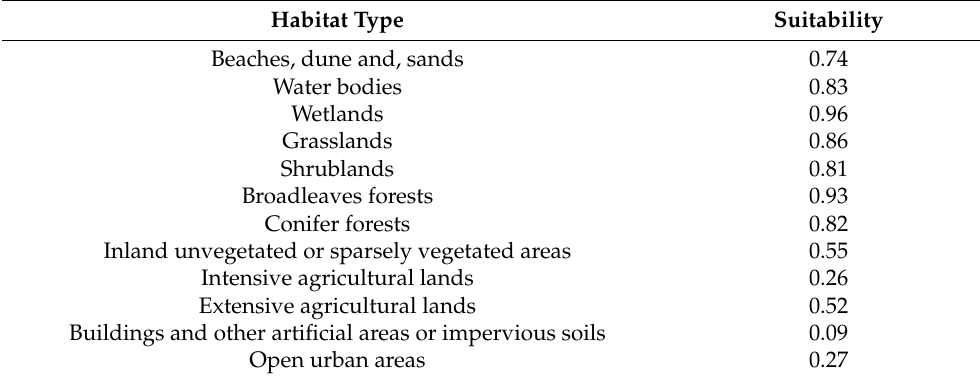
Table 1. Habitat suitability values generated by the survey (adapted from [67]).